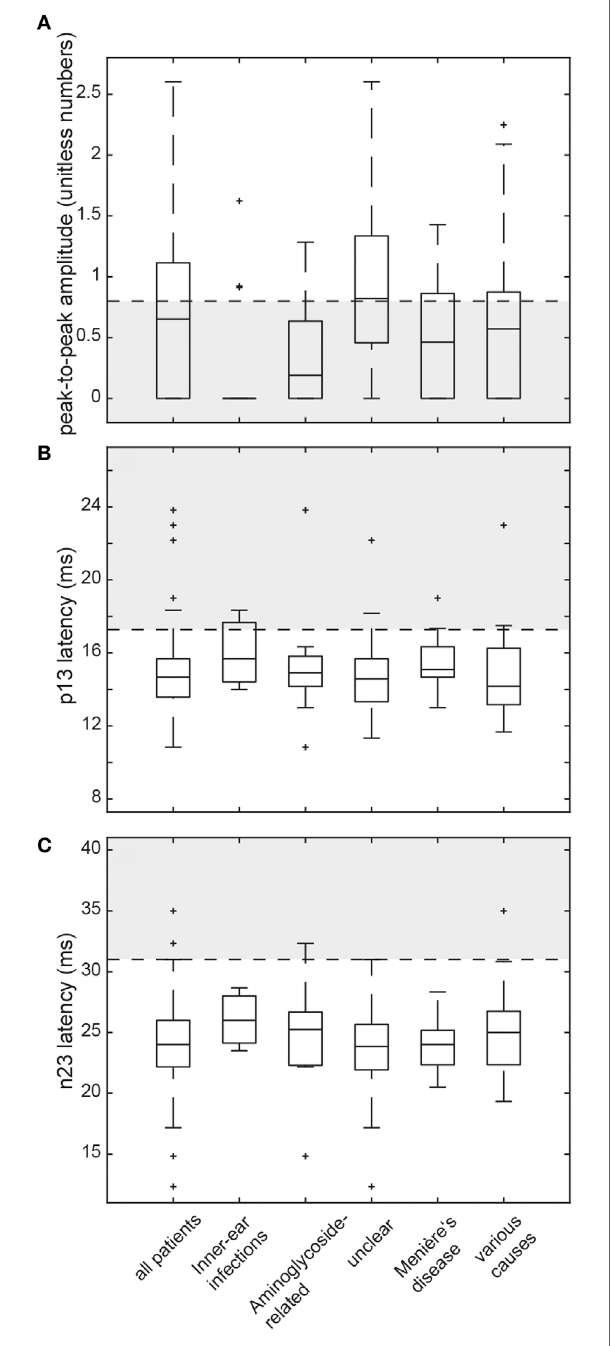
FigUre 4 | Box and whisker plots illustrating both peak-to-peak amplitudes (unitless numbers) and latencies (ms) for cervical vestibular-evoked myogenic potentials (cVEMPs) in all patients. For peak-to-peak (p13–n23) amplitudes (a) , a horizontal dashed line refers to the lower limit or normal (i.e., the 5th percentile of amplitudes measured in the healthy controls). The gray shaded area below indicates significantly reduced amplitudes. For both p13 latencies (B) and n23 latencies (c) , the upper limit of normal (i.e., the 95th percentile of latency values in the healthy controls) is indicated by a horizontal dashed line. The gray shaded area above refers to significantly increased latencies. For a detailed explanation of the boxes and whiskers, see figure legend of Figure 3 . Note that subjects with absent cVEMP responses are not shown on this